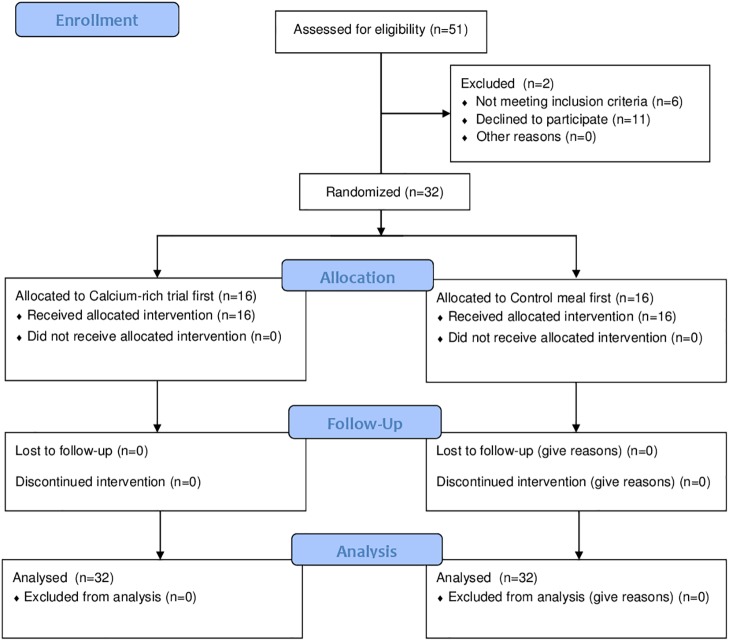
Flow chart of subject recruitment, group allocation and analysis.